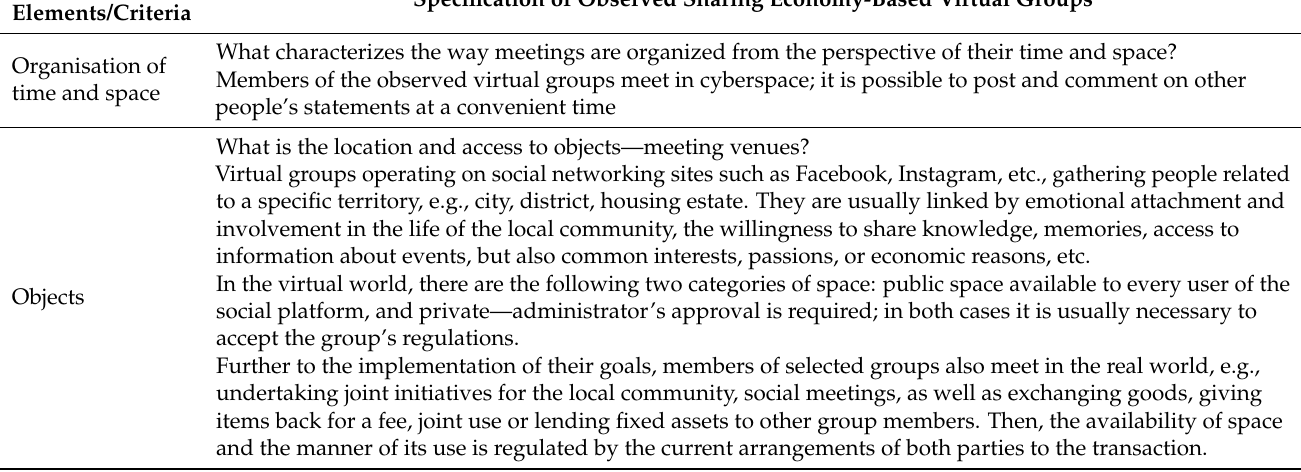
Table 4. Characteristics of virtual groups operating within the sharing economy, and at the same time connecting members of a specific local